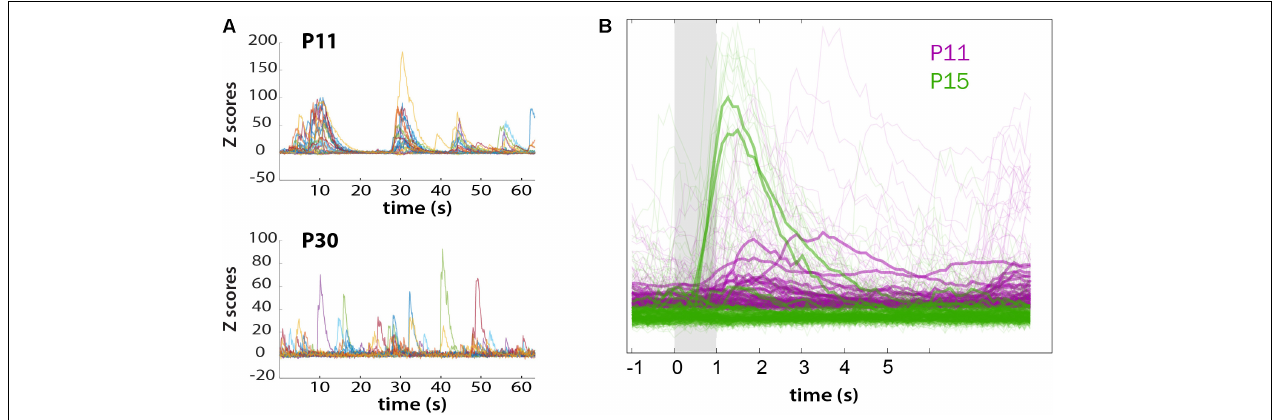
FIGURE 7 | Loss of synchronous spontaneous activity of L2/3 neurons in developing barrel cortex coincides with their ability to respond to whisker stimuli between P11 and P15. (A) Overlay of fluorescent traces of spontaneous activity of the neurons in Figure 6A field of view. Different color traces are from different neurons ( n = 24). (B) Neuronal activity is time-locked to whisker stimulation at P15, but not at P11. Traces were aligned to whisker stimulus and averaged over all 10 stimuli (bold